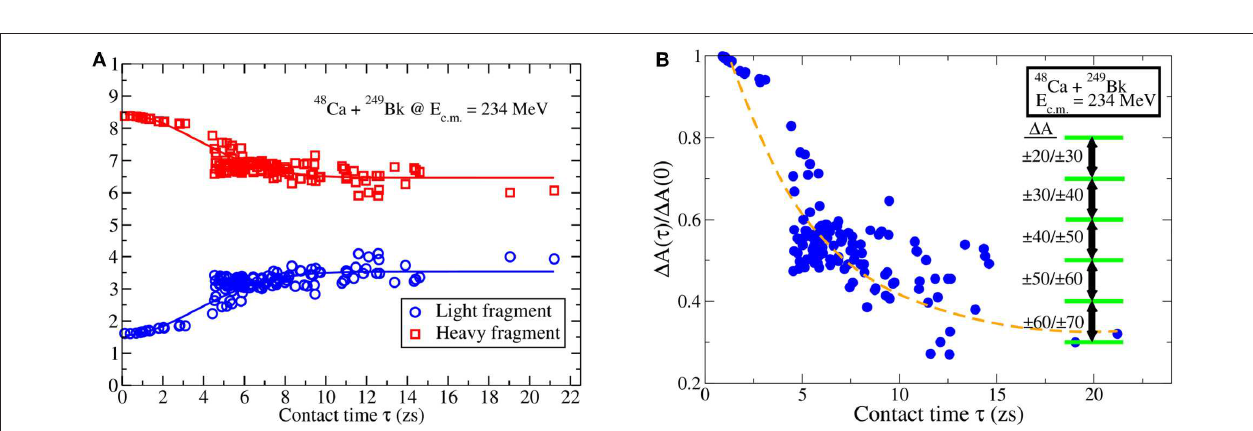
FIGURE 5 | (A) Mass ratio of fragment masses as a function of contact time at E c.m. = 234 MeV for the reaction 48 Ca + 249 Bk. The solid lines show possible fits. (B) The ratio of the final and initial fragment masses as a function of contact time for the same reaction. The dashed line shows one possible fit.